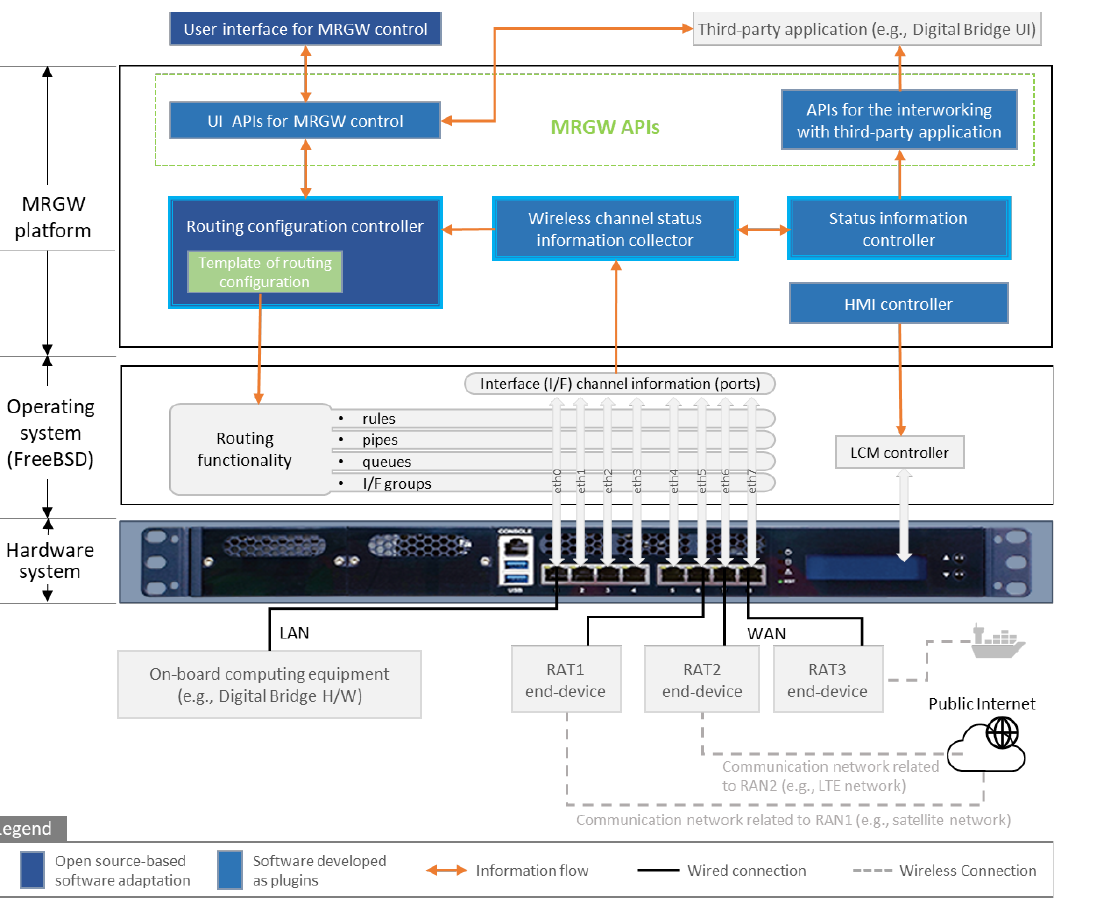
Figure 2. MRGW functional architecture.